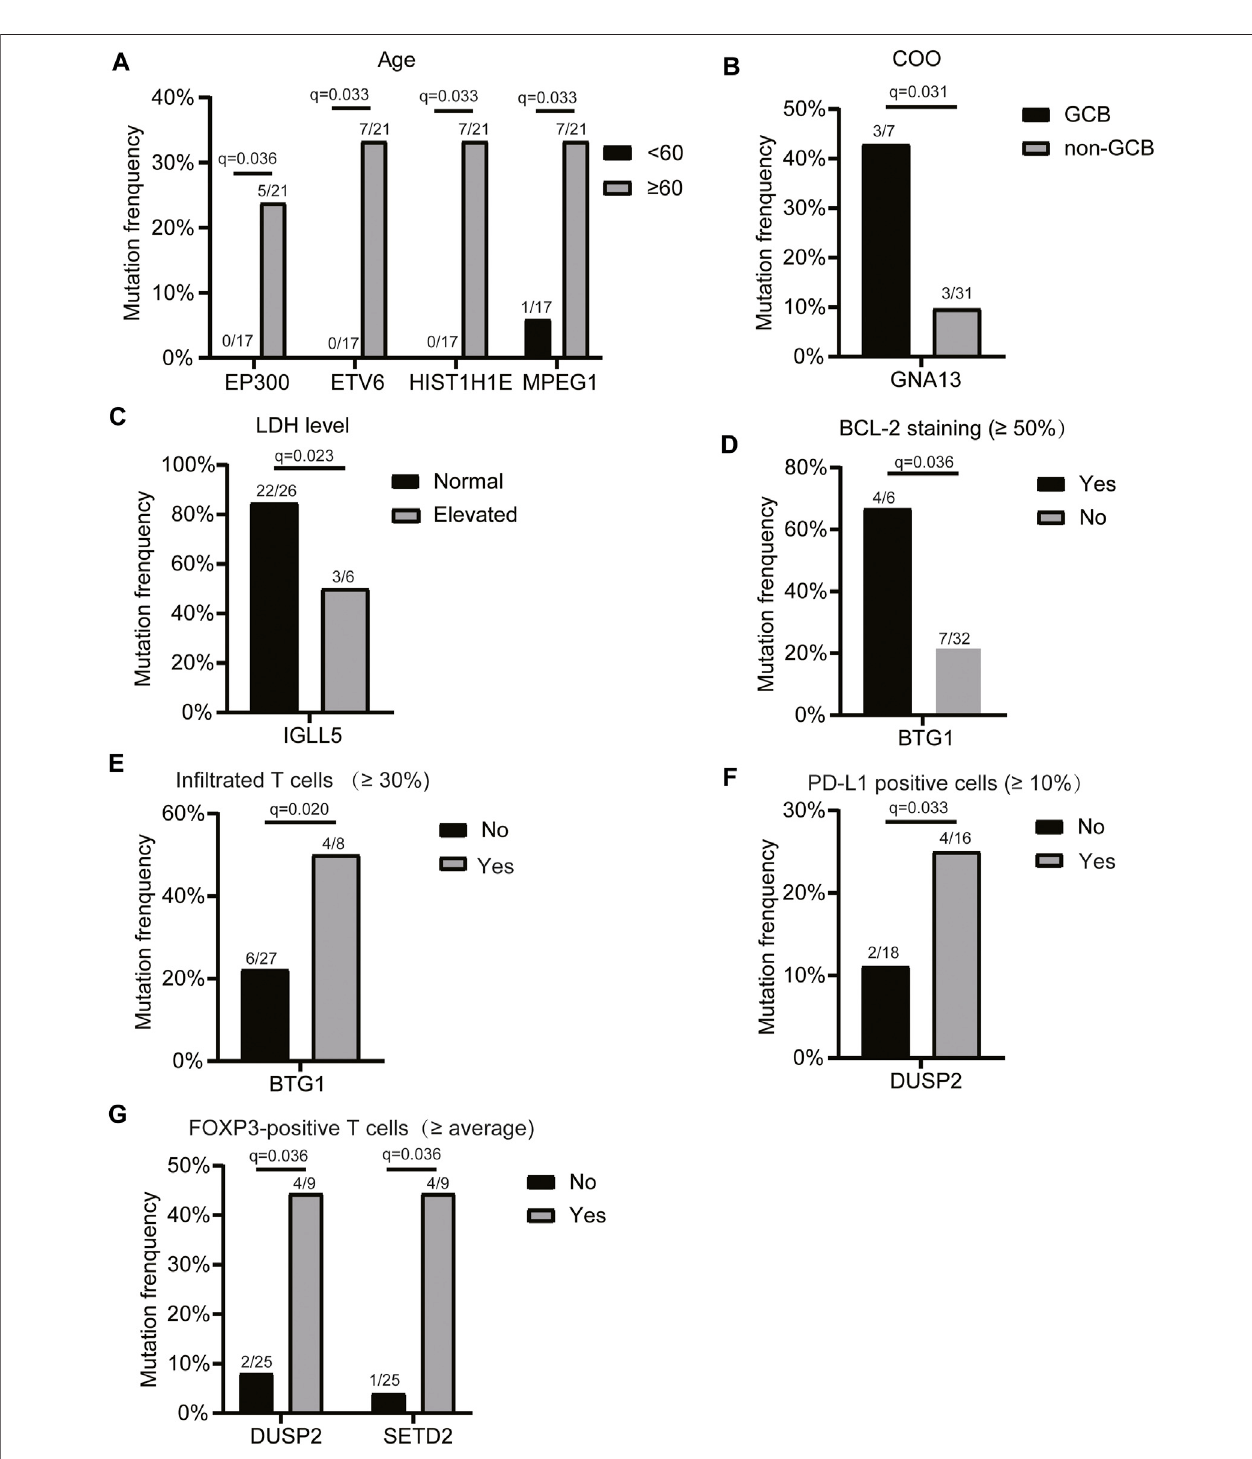
FIGURE 2 | Relationship between the mutation pro fi les and clinicopathologic features of patients with primary CNS DLBCL. Genes with signi fi cantly different mutation frequencies in primary CNS DLBCLpatientswith different (A) ages, (B) COO classi fi cations, (C) LDH levels, (D) BCL2 staining, (E) in fi ltrated Tcell populations, (F) PD-L1-positive cell populations, and (G) FOXP3-positive T cell populations. The mutation count/total count and q-value were shown in the histograms.